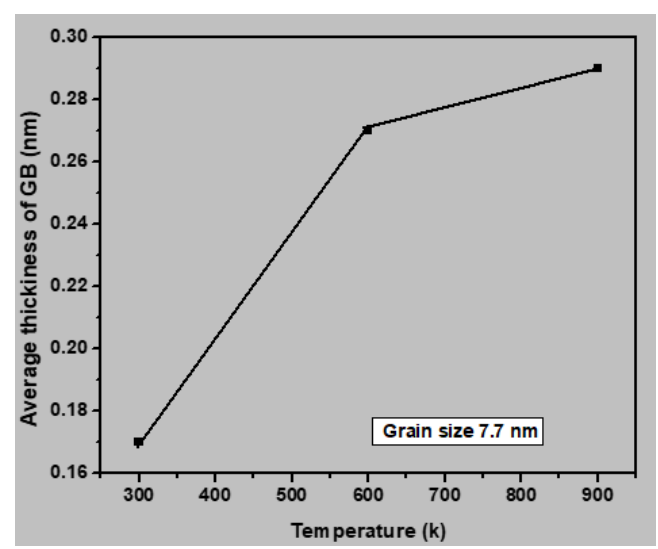
Figure 13. Average grain boundary thickness for the nanocrystalline stainless steel sample with an average grain size of 7.7 nm with respect to temperature (300, 600, or 900 K).